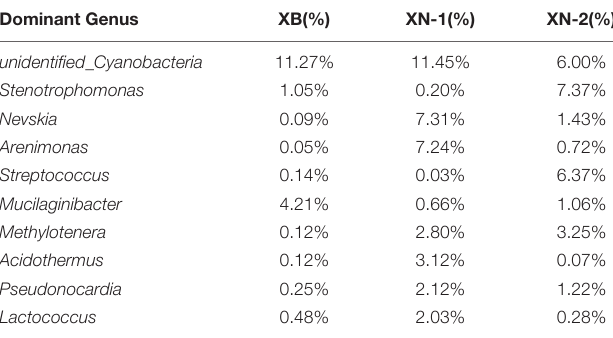
TABLE 2 | Relative abundance of dominant bacterial species among samples.